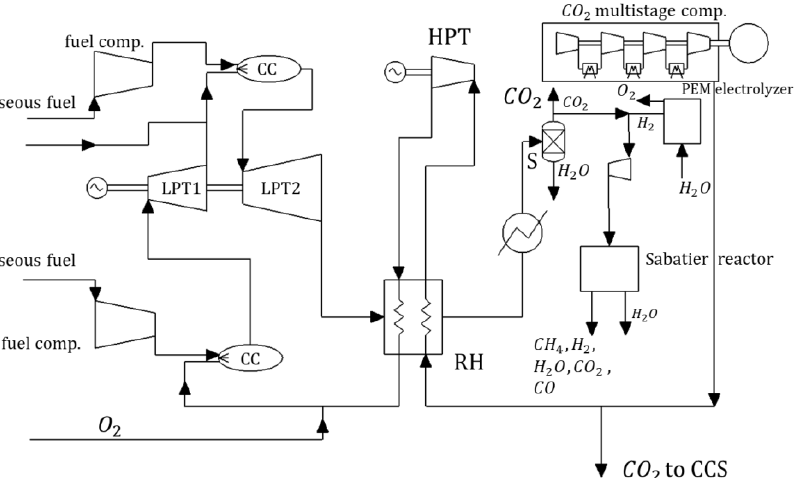
Figure 26. Schematic diagram of MATIANT cycle with synthetic methane synthesis [42]. Comp. — compressor; CC — combustion chamber; LPT — low-pressure turbine; HPT — high-pressure turbine; RH — regenerative heat exchanger; S — separator.